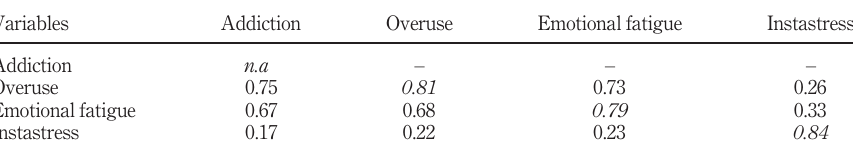
Table II. Discriminant validity